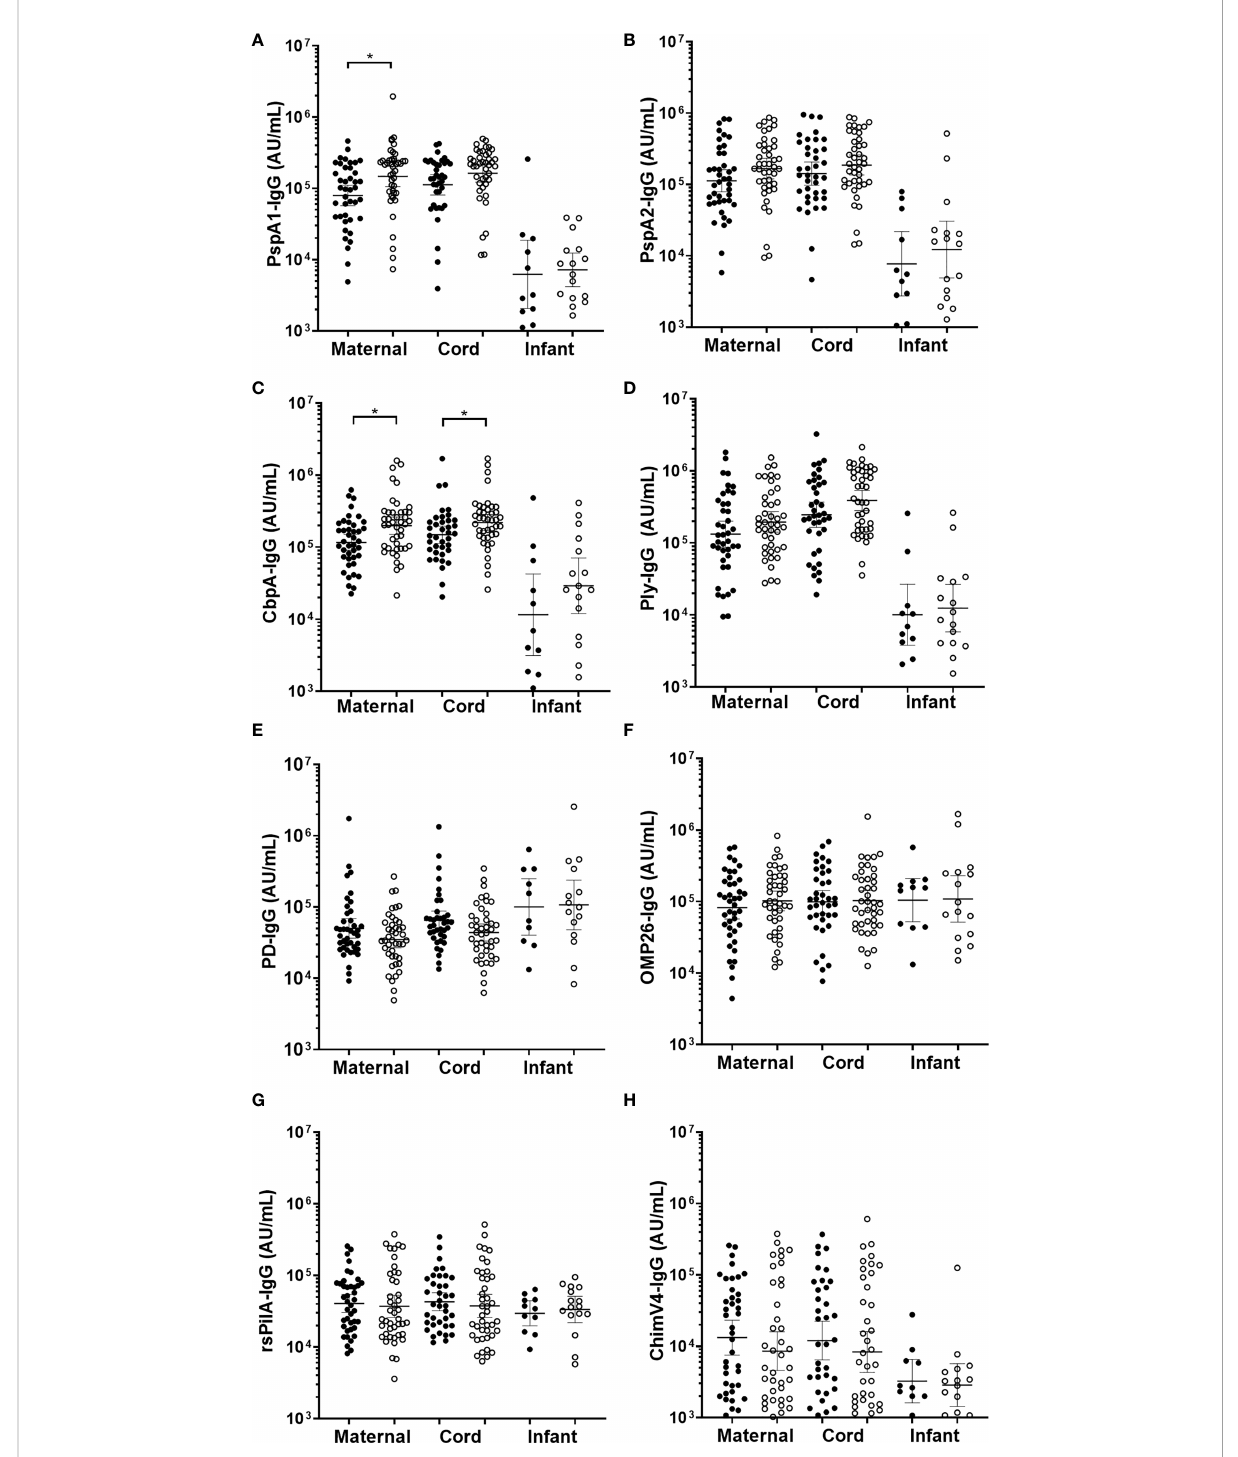
FIGURE 4 IgG antibodies against Streptococcus pneumoniae and Haemophilus in fl uenzae antigens in maternal, cord and infant sera from matched mother-infant pairs, separated based on otitis media diagnosis in the fi rst 7-months of life or not. Each point represents sera IgG titres against S. pneumoniae antigens (A) PspA1, (B) PspA2, (C) CbpA, (D) Ply and H. in fl uenzae antigens (E) PD, (F) OMP26, (G) rsPilA and (H) ChimV4. PspA1, pneumococcal surface protein A family 1; PspA2, pneumococcal surface protein A family 2; CbpA, choline-binding protein A; Ply, pneumolysin. Protein D; OMP26, outer membrane protein 26; rsPilA, recombinant soluble pilus A protein; ChimV4, chimeric vaccine antigen 4 (rsPilA and P5). *p-value <0.05, Unpaired t-tests were conducted on the logarithmically transformed data. With otitis media diagnosis = open